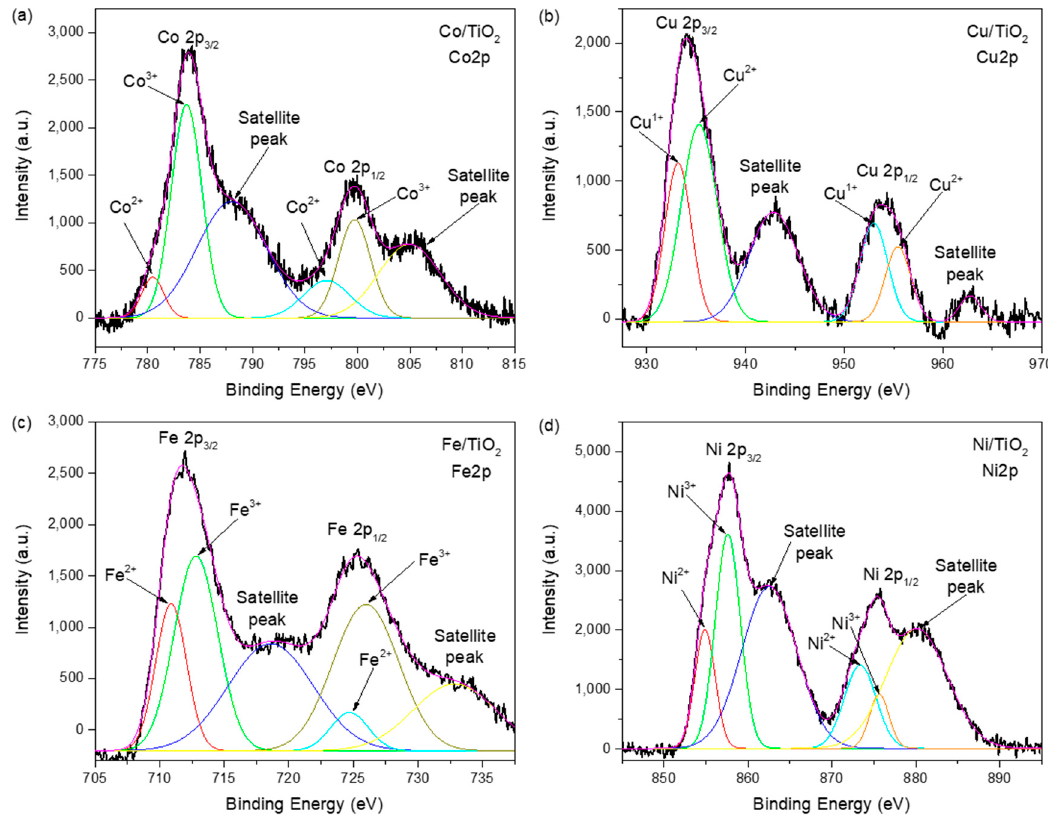
Figure 9. Higher-resolution deconvoluted XPS spectra of: ( a ) Co/TiO 2 , ( b ) Cu/TiO 2 , ( c ) Fe/TiO 2 and ( d ) Ni/TiO 2 .